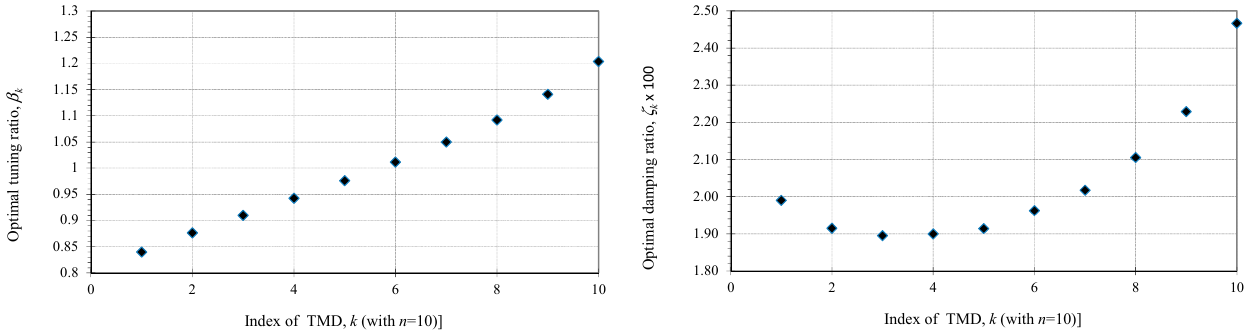
ζ β and damping ratios t of the individual TMD for 0.05 μ= k k